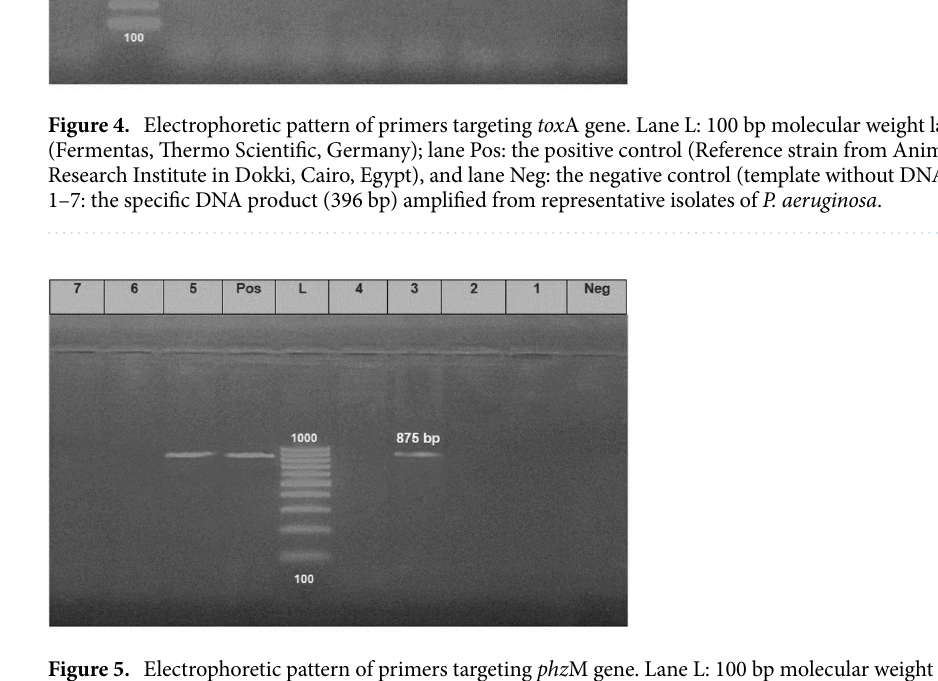
Figure 5. Electrophoretic pattern of primers targeting phz M gene. Lane L: 100 bp molecular weight ladder (Fermentas, Thermo Scientific, Germany); lane Pos: the positive control (Reference strain from Animal Health Research Institute in Dokki, Cairo, Egypt), and lane Neg: the negative control (template without DNA). Lanes 1–7: the specific DNA product (875 bp) amplified from representative strains of P. aeruginosa .